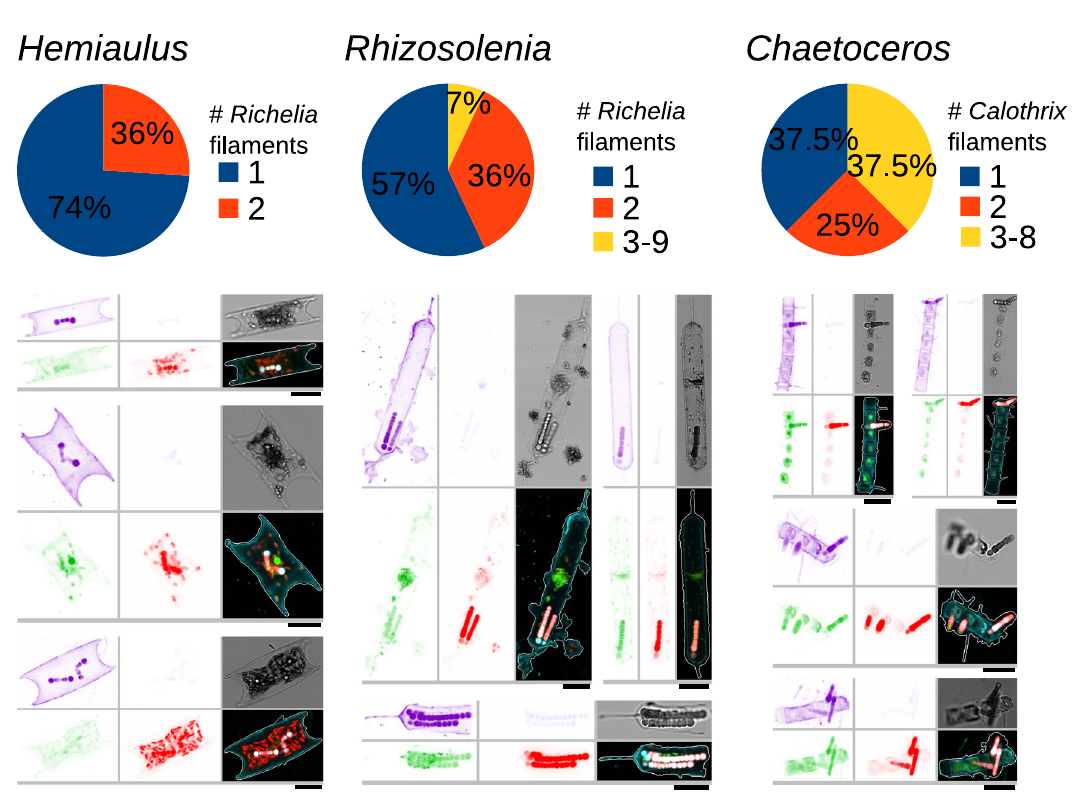
Fig. 2 Variation in the number of Richelia / Calothrix fi laments among the diatom-diazotroph associations observed by high-throughput confocal microscopy. Examples of images are shown. Clockwise from top-left, the displayed channels for each micrograph correspond to: cell surface (cyan, AlexaFluor 546 dye), DNA (blue, Hoechst dye), the bright fi eld, cellular membranes (green, DiOC6 dye), chlorophyll auto fl uorescence (red), and the merged channels. The size bar at the bottom left of each microscopy image corresponds to 10 μ